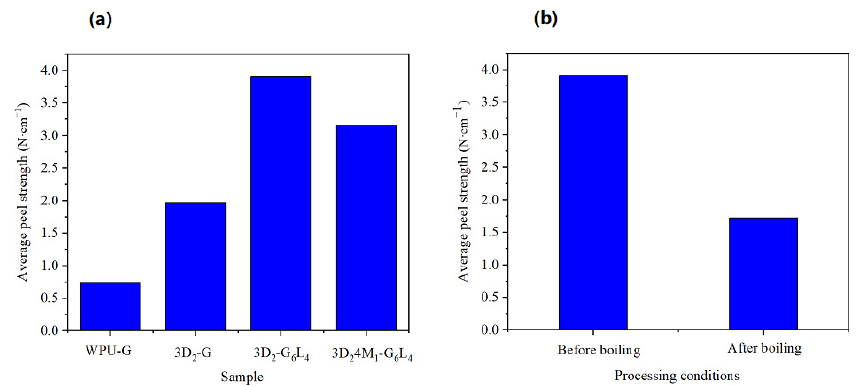
Figure 6. The effects of different chain extension methods and boiling on the adhesion properties of the samples. ( a ) Influence of different chain extension methods; ( b ) influence of boiling.